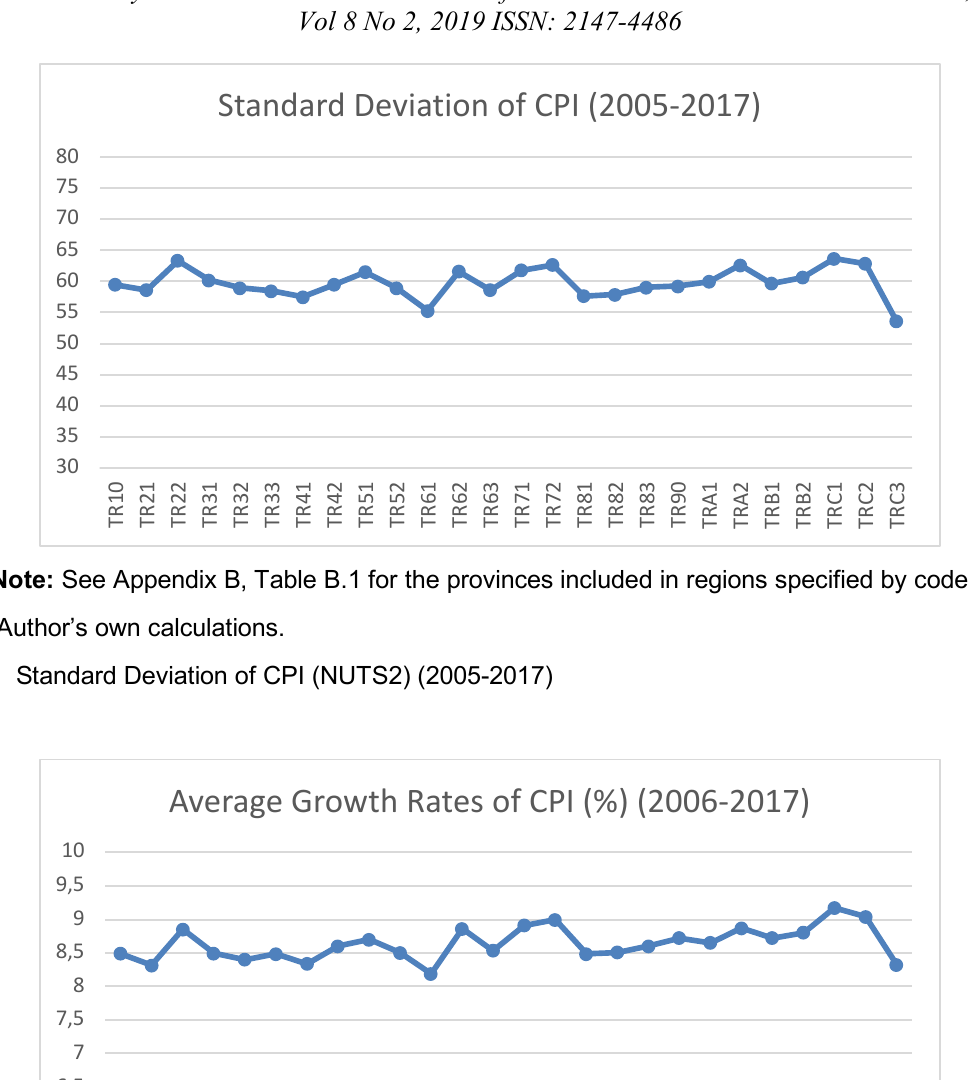
Moreover, the comparison of beta convergence model (both for conditional and unconditional), sigma convergence and coefficient of variation with real values by using CPI and GDP deflator for NUTS2 level regions of Turkey is given in Appendix A since CPI on regional level is only valid for NUTS2. It can be observed that the results are almost the same so that using GDP Deflator is not a handicap under these conditions rather due to the reasons that are mentioned, it is relatively better than using